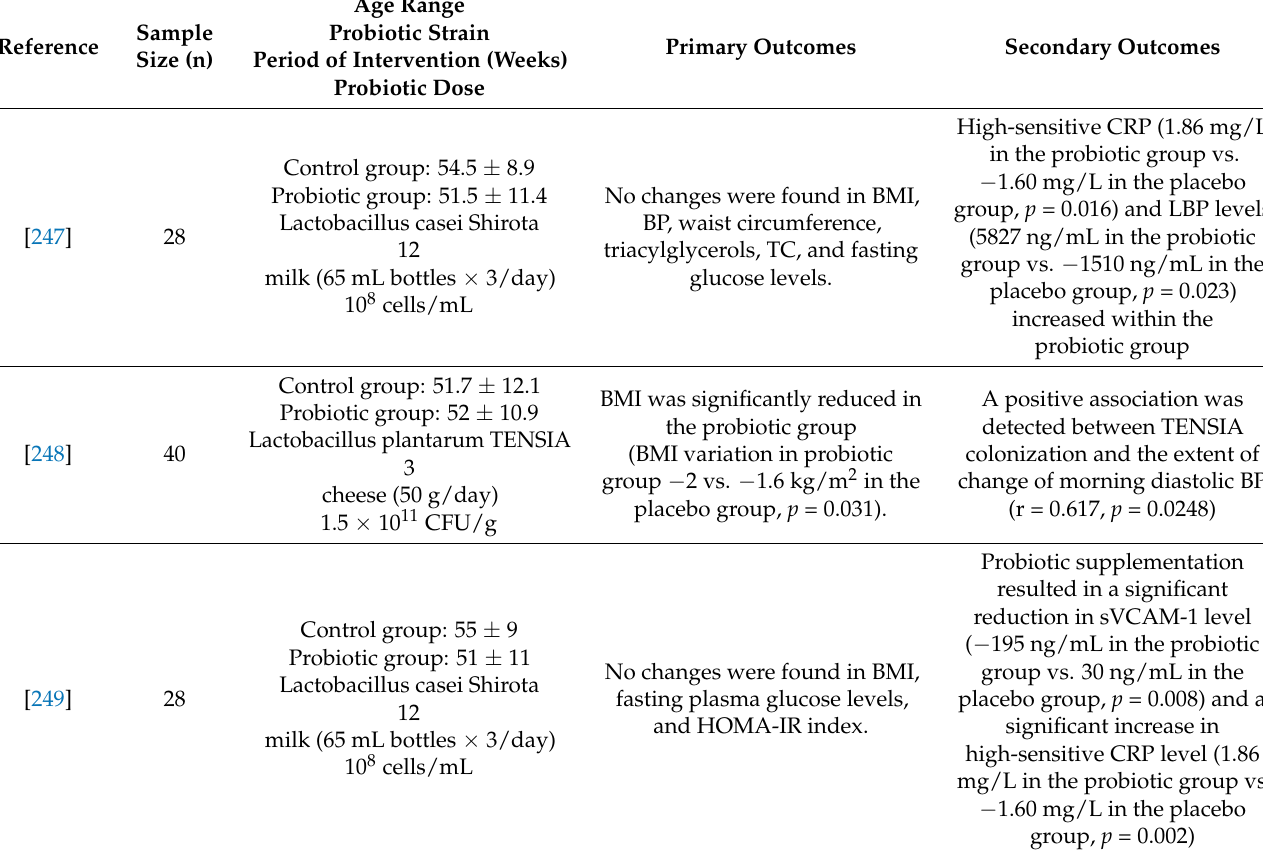
Table 6. Association between metabolic syndrome and